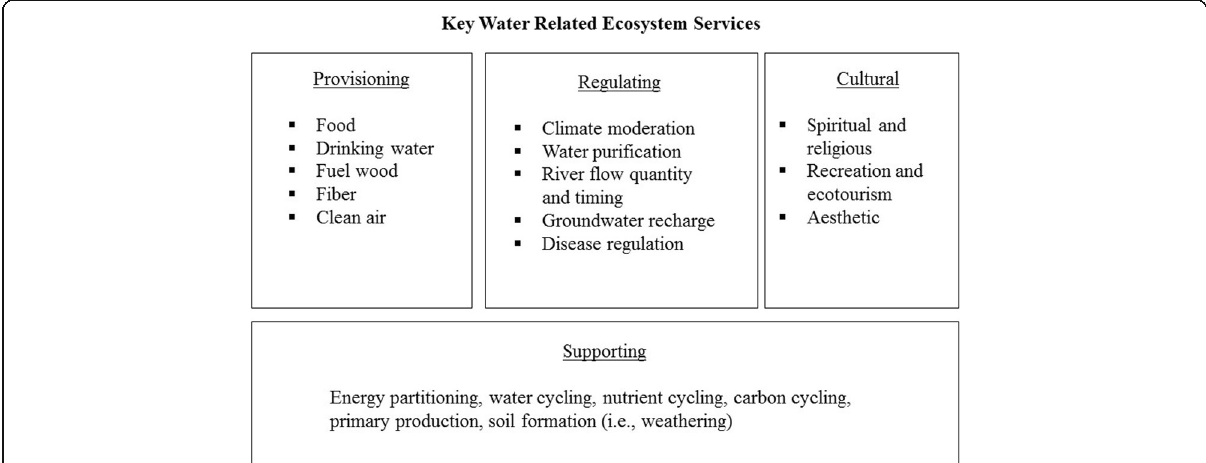
Fig. 1 Relationships between ecohydrological processes and key water-related ecosystem services (Modified from Millennium Ecosystem Assessment